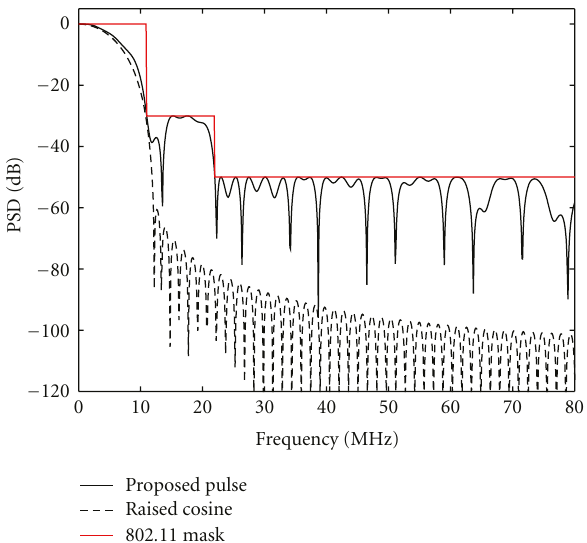
Figure 6: SER performance for di ff erent pulse-shapes for symbol rate 10 M/sec, with CFOs randomly chosen within the range [0,0 . 001 /T s ].